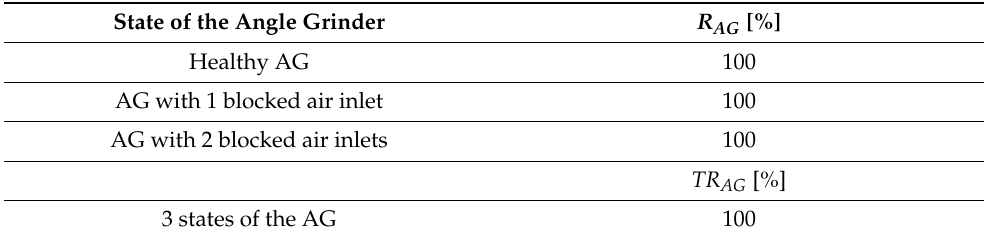
Table 4. Values of TR AG and R AG for using of BCAoMID − F, the sum of pixels, and SVM. State of the Angle Grinder